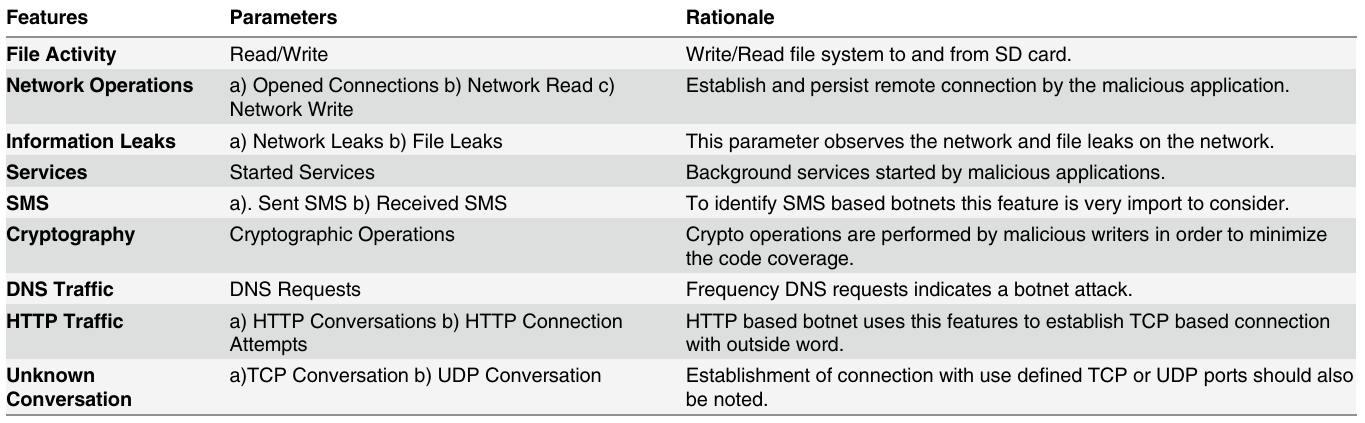
Table 3. Feature